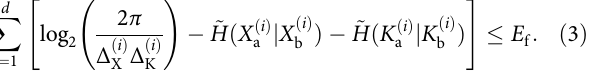
; X Þ as it is re fi ned to higher a b